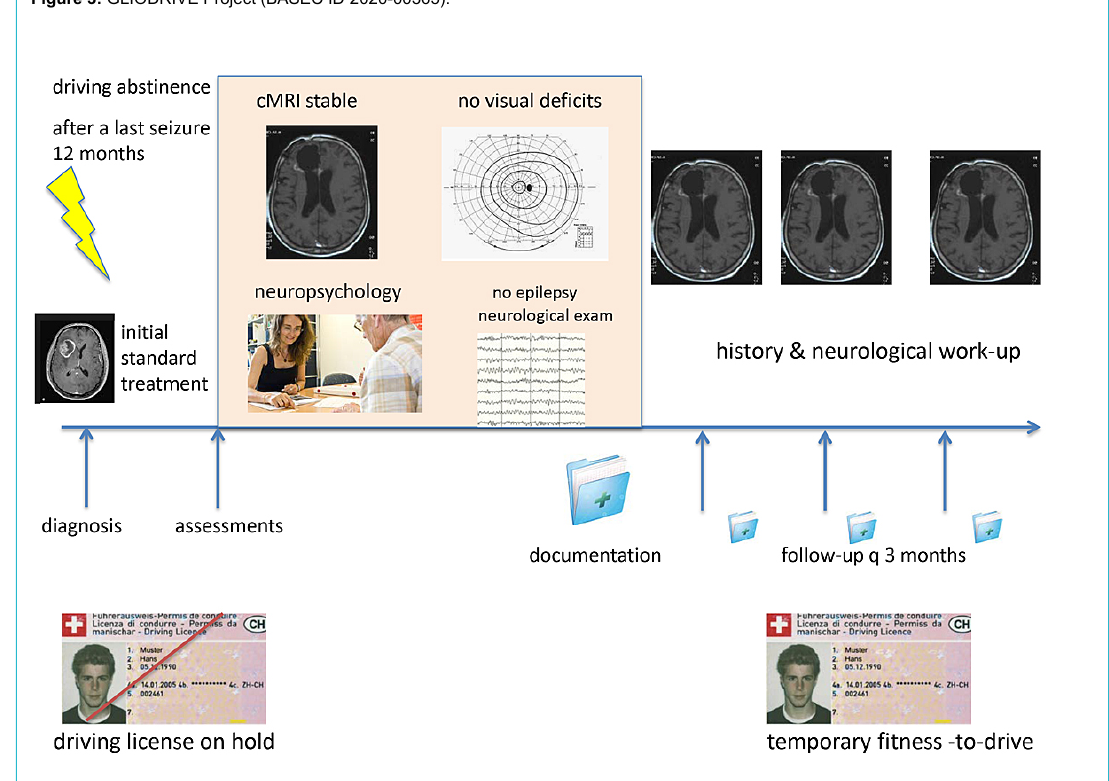
Figure 3: GLIODRIVE Project (BASEC ID